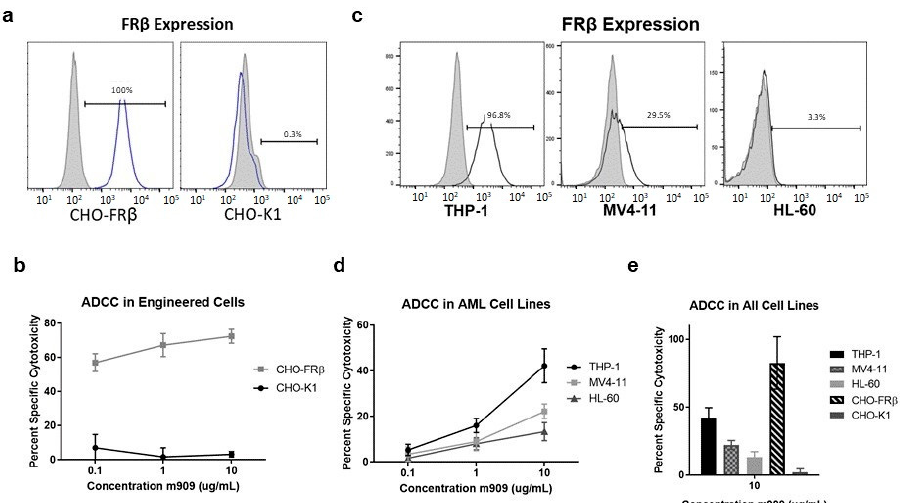
Figure 1. FR β expression analysis and targeting using m909 antibody. ( a ) FR β is expressed at 100% on the engineered cell line (CHO-FR β ). No expression is detected in the parental control (CHO-K1). ( b ) Antibody-dependent cytotoxicity assay (ADCC) with CHO-FR β cells, NK cells at E:T ratio 10:1 and increasing doses of m909. Specific cytotoxicity is calculated by subtracting the percentage of cell death with no antibody. Representative results from one of two independent experiments with triplicate samples in each experiment are shown. ( c ) FR β expression on immortalized AML cell lines THP-1, MV4-11, and HL-60. ( d ) ADCC assay at increasing doses of m909 for AML cell lines incubated with NK cells at E:T of 10:1 demonstrating a dose-dependent and expression-dependent response. Representative results from one of three independent experiments with triplicate samples per concentration and cell type are shown. ( e ) Specific cytotoxicity for ADCC assay for each cell line at 10 µ g/mL m909 using NK cells from the same donor performed with triplicate samples. All error bars represent standard deviation.